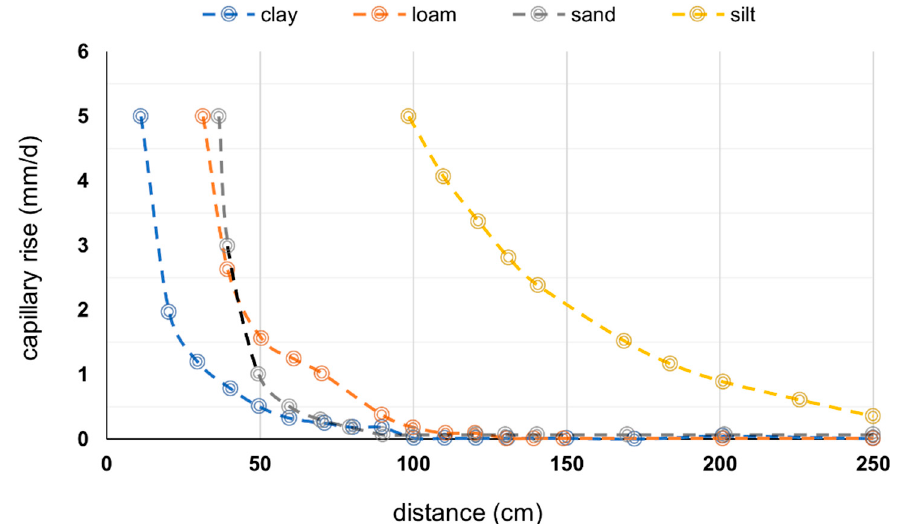
Figure 5. Potential daily capillary rises rates (Q pot ) in mm/d as a function of the distance between the groundwater table and effective root zone for different soil textures according to the German Soil Classification System [51].